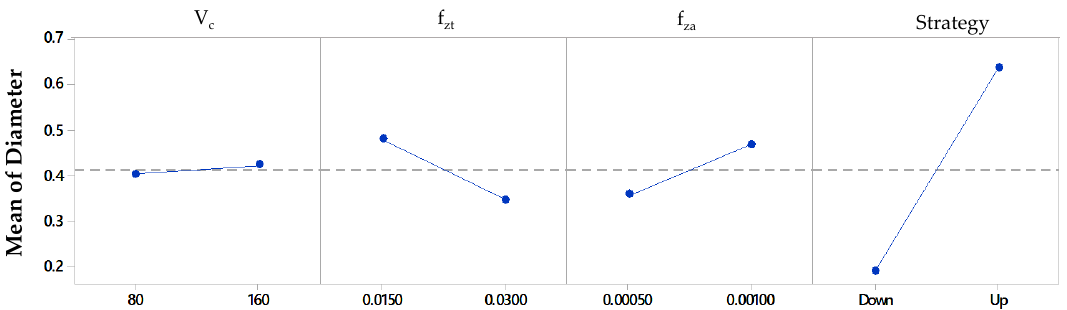
Figure 10. Main effects plot for Ra. Figure 10. Main e ff ects plot for Ra.